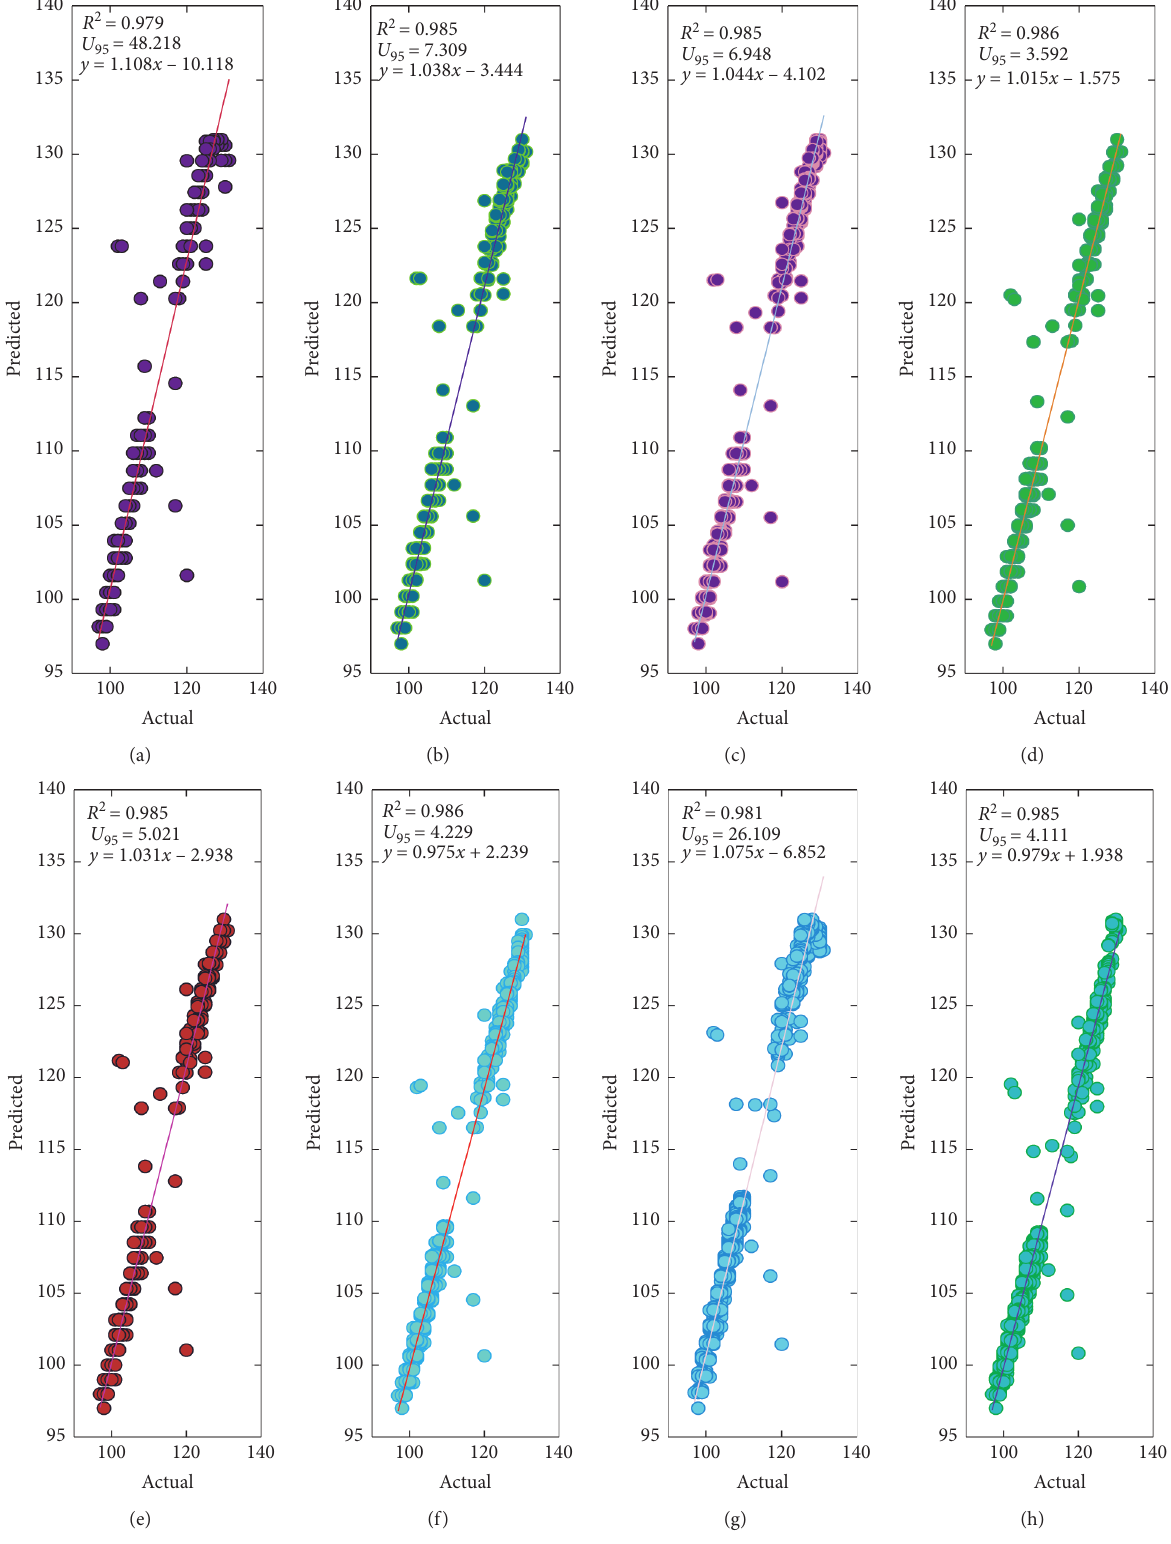
Figure 8: ELM models for USGS 14181500 station: coefficient of determination. (a) ELM-M1. (b) ELM-M2. (c) ELM-M3. (d) ELM-M4. (e) ELM-M5. (f) ELM-M6. (g) ELM-M7. (h)